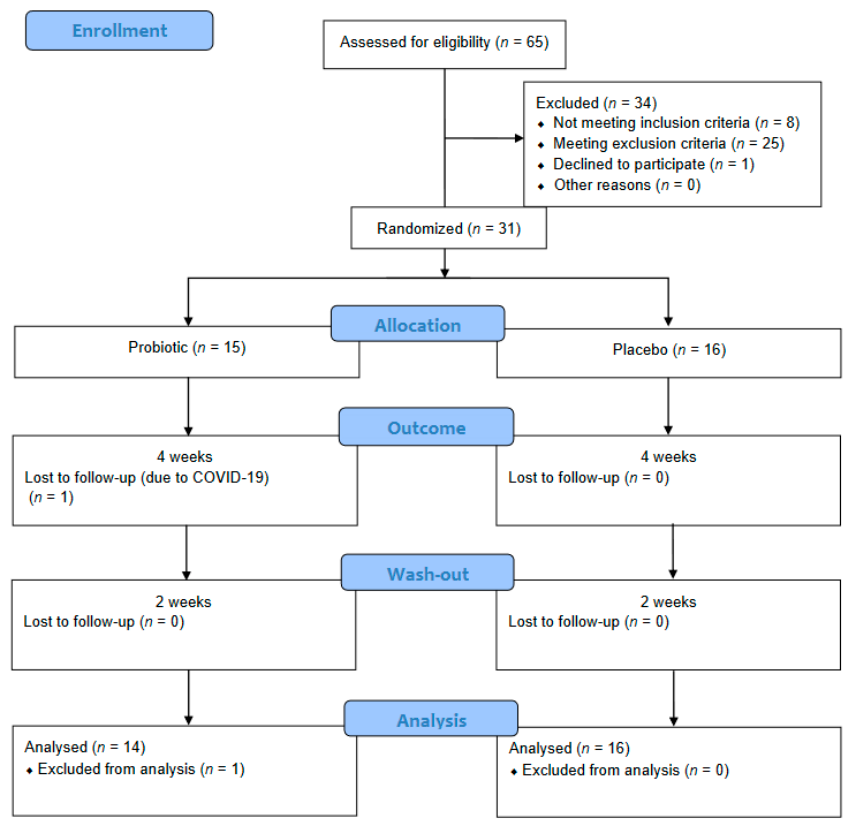
6 of 14 Table 3. Characteristics of subjects at inclusion. Parameter